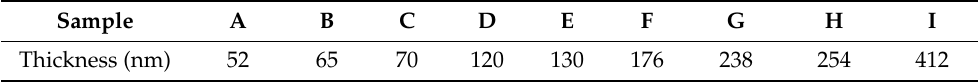
Figure 4. SEM images of the as-deposited β -Ga 2 O 3 thin films at different molar concentrations and drying temperatures. Table 2. Thickness values of the samples prepared under different conditions.